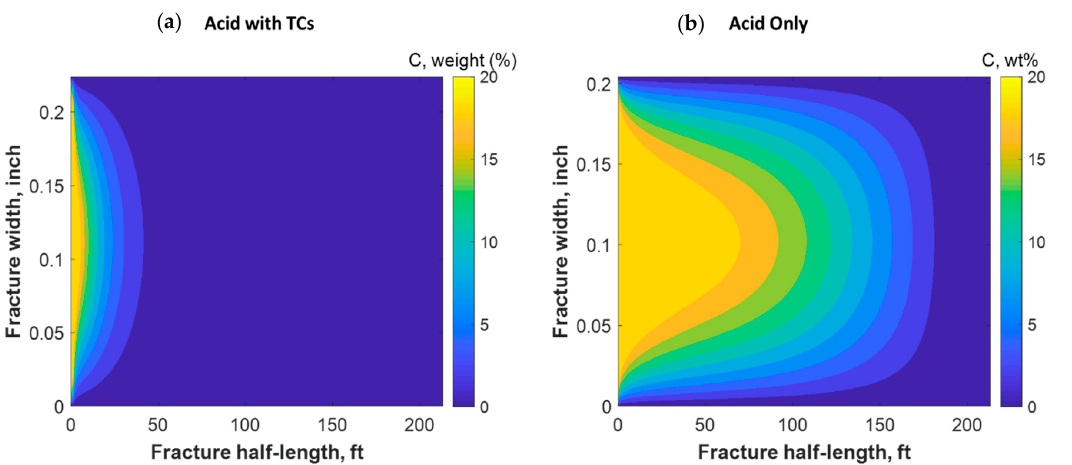
Figure 18. Comparison of acid concentration profiles when ( a ) acid was injected with TCs versus the ( b ) acid-only injection.